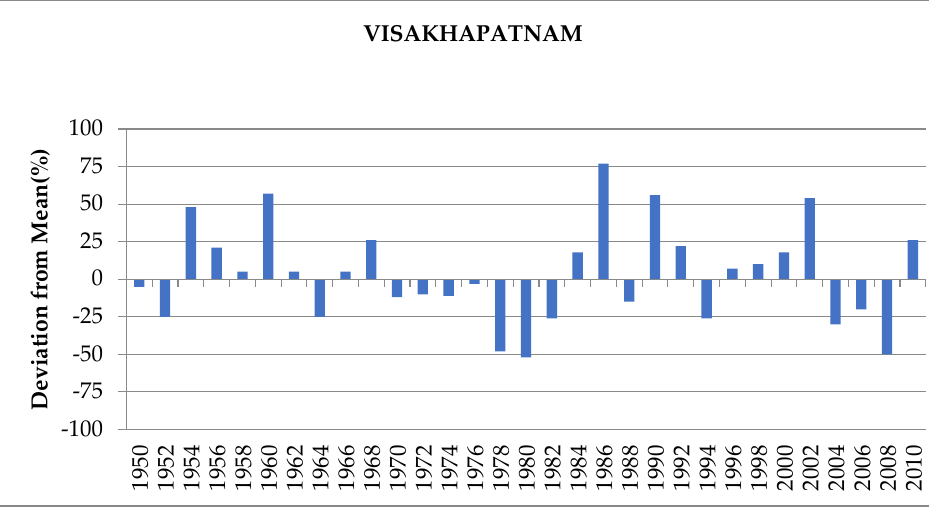
Figure 8. Visakhapatnam.